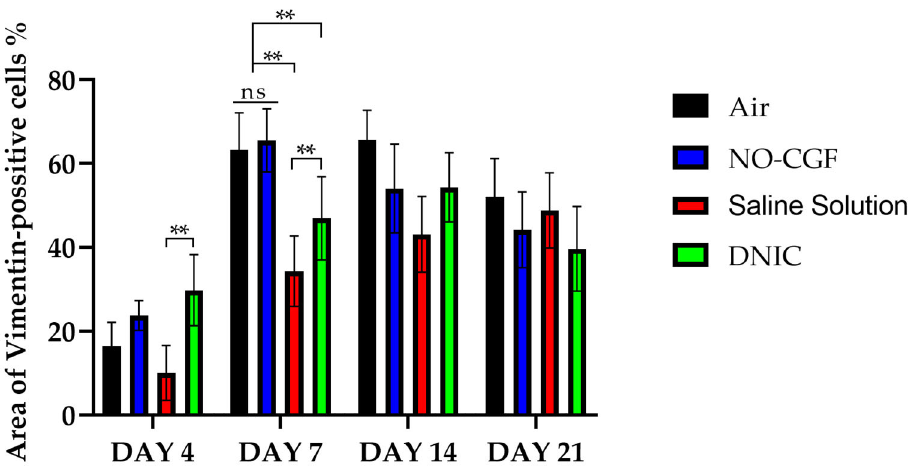
Figure 11. Area of vimentin-positive cells, two-way ANOVA, mean values ± SD; ns—non-significant, **— p < 0.01.